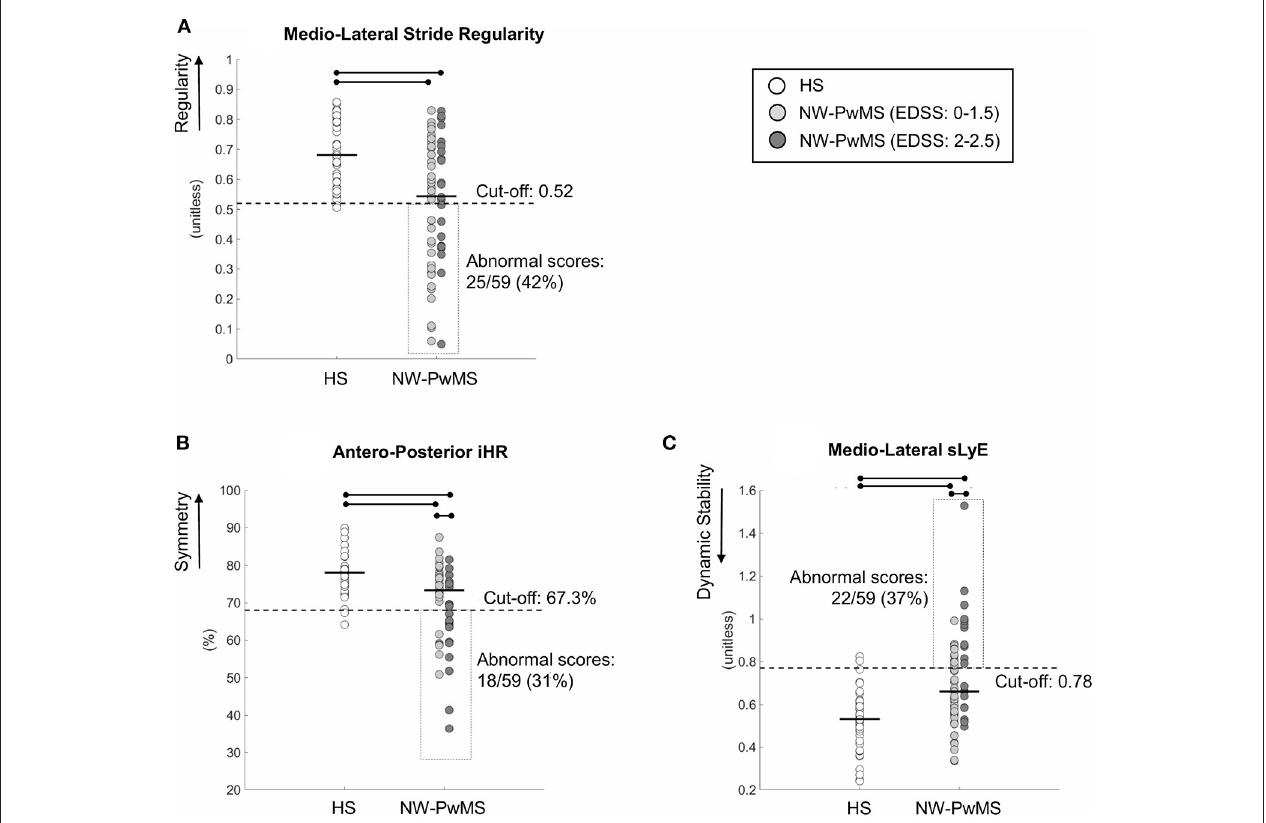
FIGURE 1 | Instrumented parameters describing walking with horizontal head turns (WHHT) in healthy subjects (HS) and early-stage people with MS showing normal walking (NW-PwMS). (A) Mediolateral Stride Regularity. (B) Anteroposterior iHR (improved harmonic ratio). (C) Mediolateral sLyE (short-term Lyapunov exponent). Each circle represents a single participant. Horizontal bold lines represent median values for each group. Horizontal lines and dots represent a statistically significant difference between groups ( p < 0.05, Kruskal–Wallis and Bonferroni–Holm test). Cut-off scores, corresponding to the 5th percentile (A,B) and the 95th percentile (C) of HS, are reported together with the number (%) of NW-PwMS showing abnormal